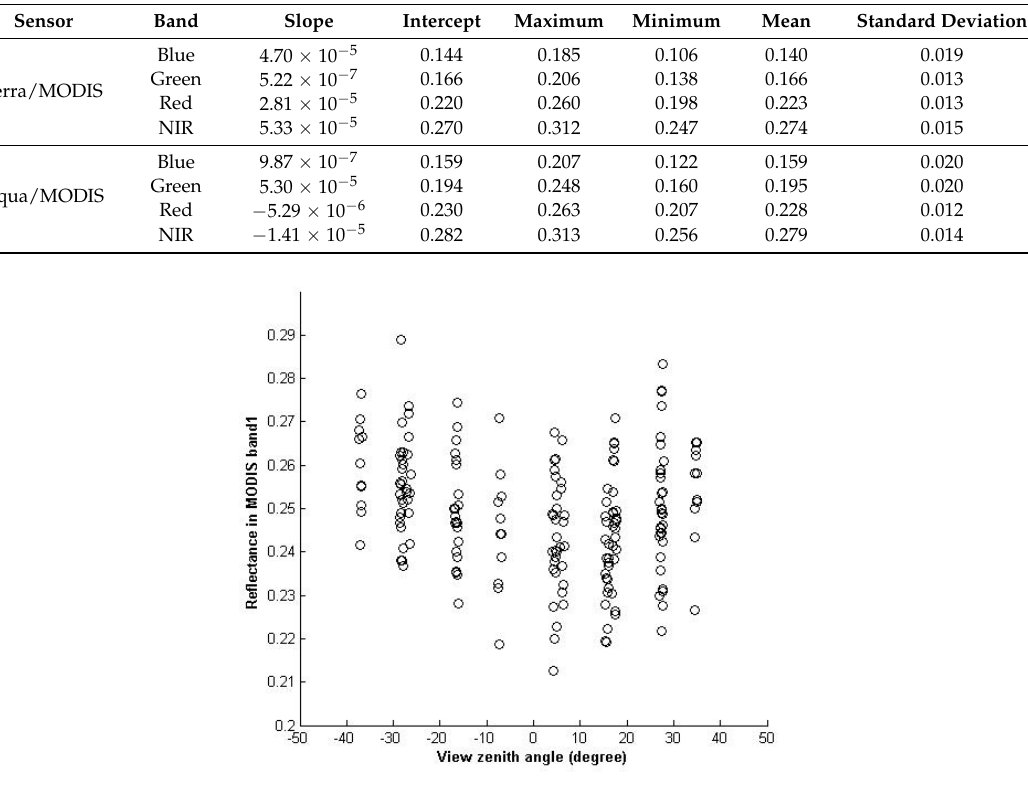
Figure 7. The calibration site’s directional characterization of the red band of Terra/MODIS. The reflectance varies with relative azimuth and solar zenith angle for each bin of view zenith angle, which shows systematic variation that is due to directional effects. The directional effect is about 15%.